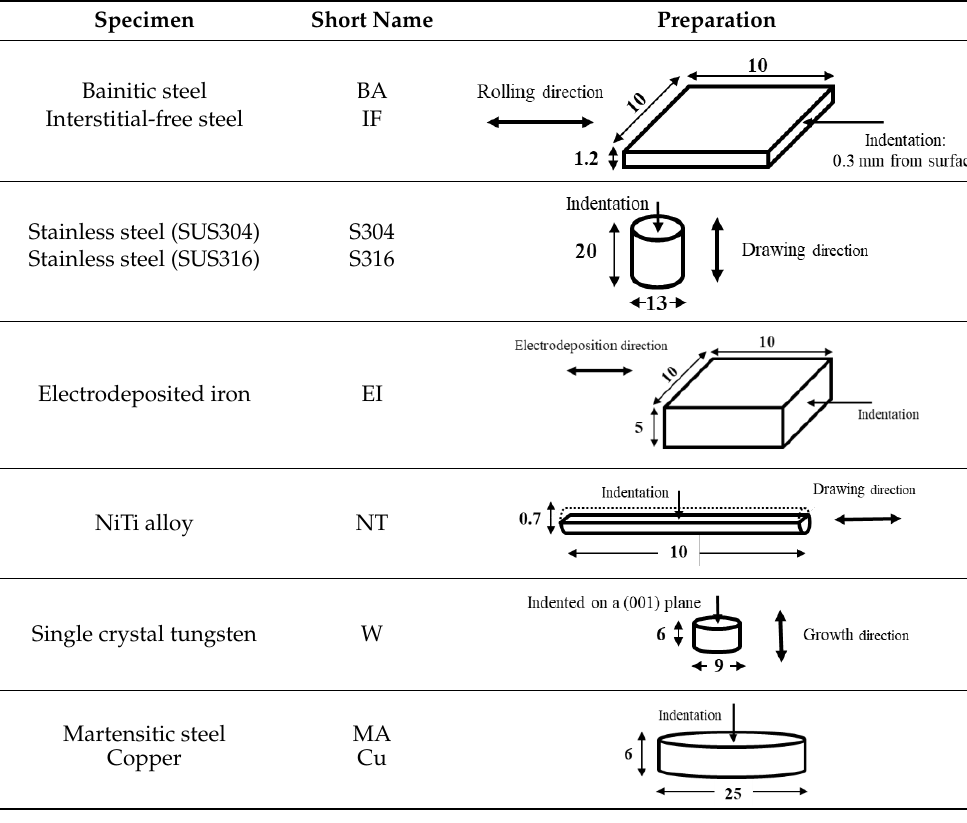
Table 2. Dimensions (mm) and preparation of nanoindentation test specimens.